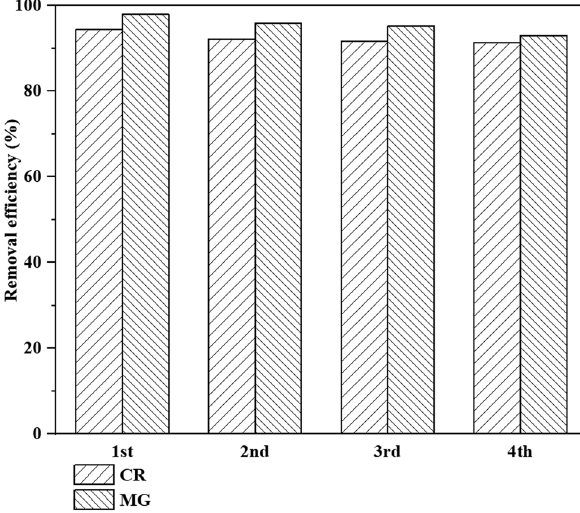
Figure 8: The CR and MG removal e ffi ciency after four times of reusing Ag/ZnCo - ZIFs. CR: pH 7.1, catalyst dosage = 150 mg L − 1 , [ H ] = 0.05 mol L − 1 , initial [ CR ] = 30 mg L − 1 , temperature = 30°C, 2 O 2 time = 45 min. MG: pH 6.0, catalyst dosage = 100 mg L − 1 , [ H 2 O 2 ] = 0.05 mol L − 1 , initial [ MG ] = 30 mg Lmg L − 1 , temperature = 30°C, time = 30